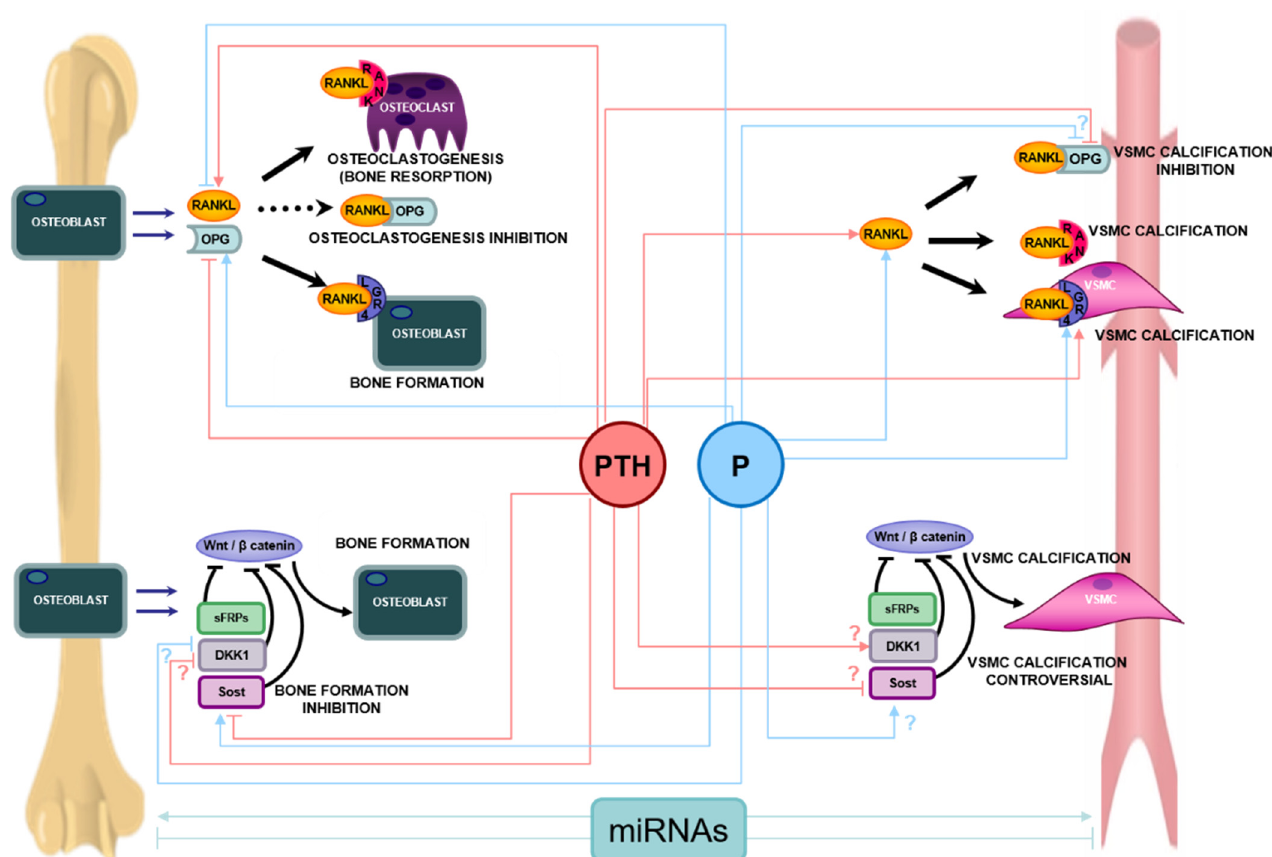
Figure 3. Main pathways of bone metabolism (RANK-RANKL-OPG-LGR4 System and Wnt/ β -catenin) and their involve- ment in vascular calcification, and main effects of parathyroid hormone (PTH) and phosphorus (P) on both pathways. In bone, the osteoblast synthesizes and secretes RANKL and OPG. The binding of RANKL to RANK in osteoclast precursors induces their activation, maturation and survival, and therefore osteoclastogenesis and bone resorption. The osteoblast also synthesizes OPG that prevents the RANKL-RANK union, inhibiting osteoclastogenesis. In addition RANKL can bind LGR4 triggering bone formation signals and bone mineralization. In vascular smooth muscle cells (VSMC), the binding of RANKL to both RANK and LGR4 induces mineralization signals and vascular calcification. The union of RANKL to OPG, prevents calcification of VSMC. The Wnt/ β -catenin’s pathway activation promotes the transcription of bone forming genes, regulating pre-osteoblast differentiation and osteoblast activity. The Wnt/ β -catenin pathway has several inhibitors such us Dickkopf1 (Dkk1), sclerostin (Sost), and the secreted Frizzle related proteins (sFRPs), which are able to block the Wnt/ β -catenin pathway, inhibiting the osteoblast differentiation and survival. The Wnt/ß-catenin pathway is also involved in the process of vascular calcification, though there is still controversy regarding the regulation of inhibitors of the Wnt/ß- catenin pathway in the process of vascular calcification. MicroRNAs (miRNAs) can regulate bone formation and/or re- sorption and mineralization but also can promote or inhibit VSMC calcification. Pointed arrow means activation and stop arrow means inhibition or blockage. In case of controversy in the literature, the most accepted option is included in the figure accompanied by a “?” symbol.